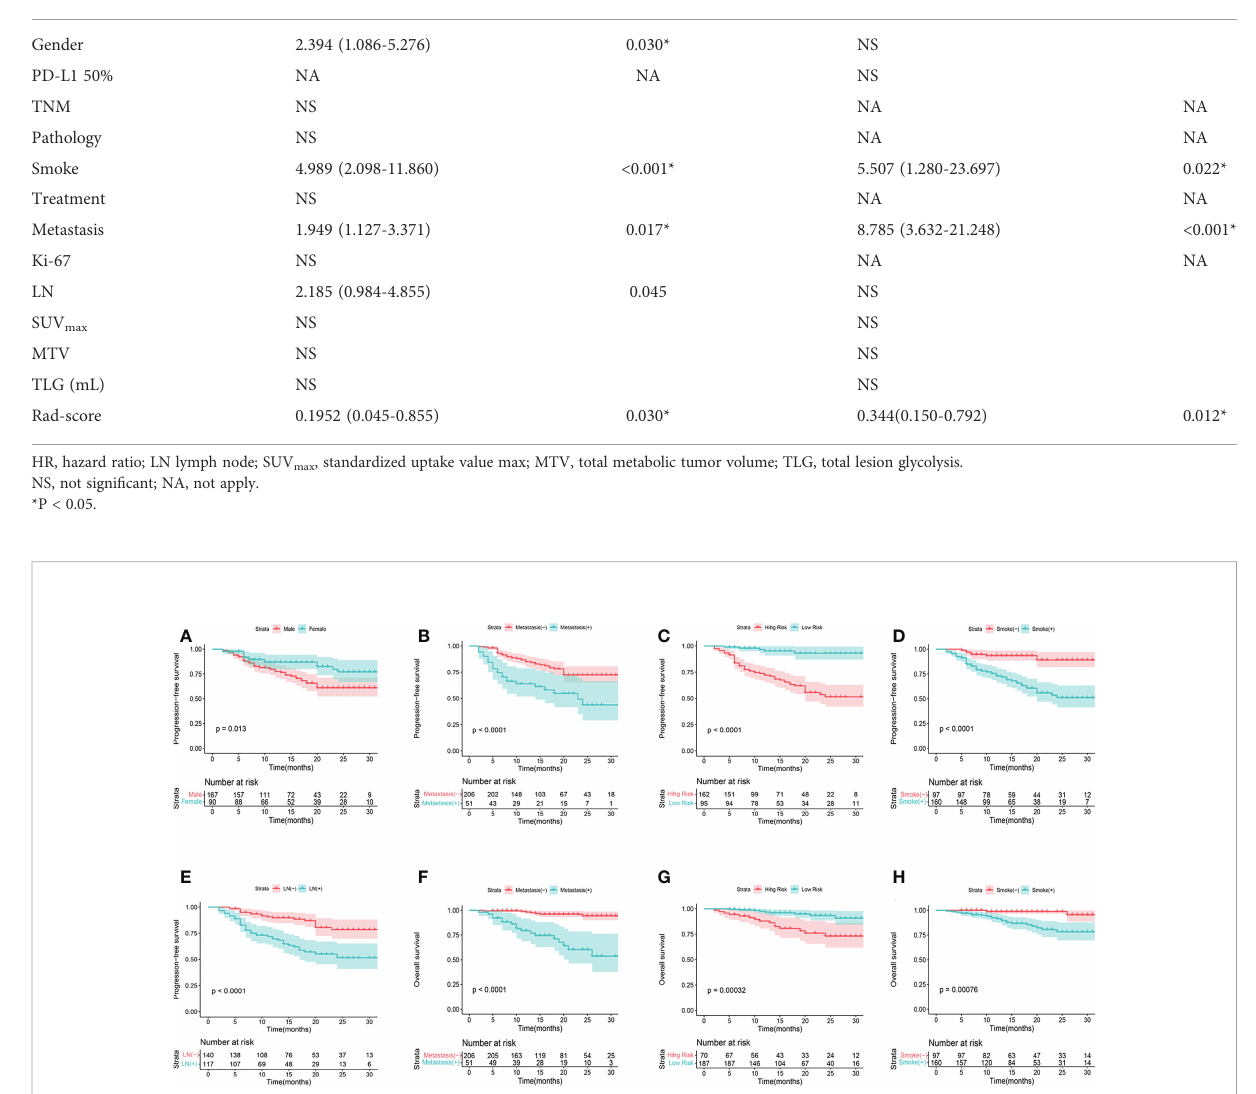
the clinical model for predicting PFS (AUC = 0.791 VS. 0.776)